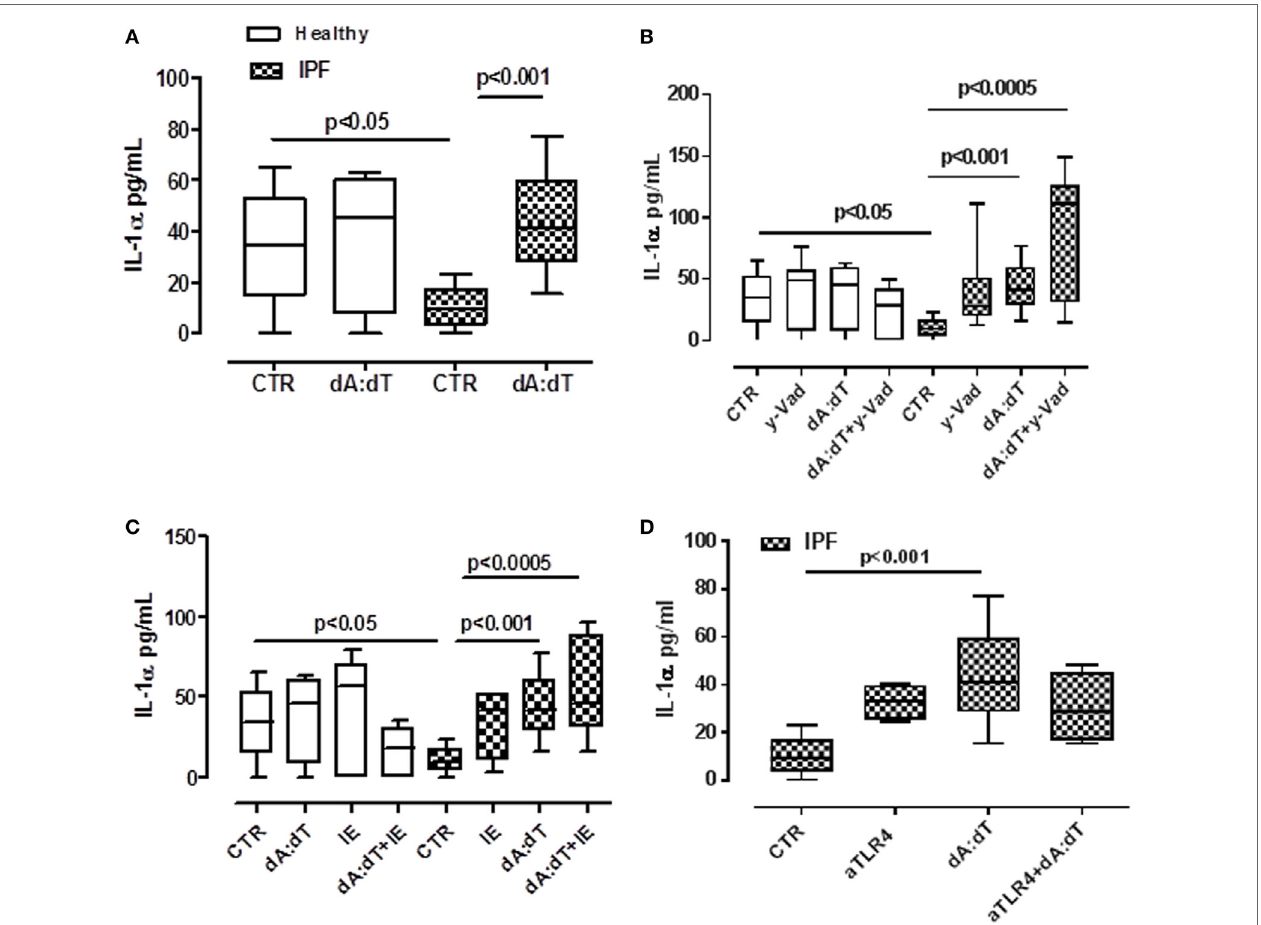
FigUre 3 | IL-1 α release from idiopathic pulmonary fibrosis (IPF)-derived peripheral blood mononuclear cells (PBMCs) is induced after absent in melanoma 2 (AIM2) inflammasome activation. (a) Poly dA:dT (dA:dT, 1 µg/ml) stimulation (5 h) of PBMCs obtained from IPF patients, significantly increased IL-1 α release compared with control; no effect was observed in healthy subjects-derived cells after dA:dT addition. The inhibition of caspase-1 by means of Ac-Y-VAD-cmk (y-VAD, 1 µg/ml) (B) or caspase-8 by means of z-IETD-fmk (IE, 0.5 µg/ml) (c) or TLR4 blockade (D) did not affect IL-1 α release, even after dA:dT treatment. Data are represented as median ± interquartile range ( n = 13). Statistically significant differences were determined by one-way ANOVA followed by Bonferroni’s multiple comparison